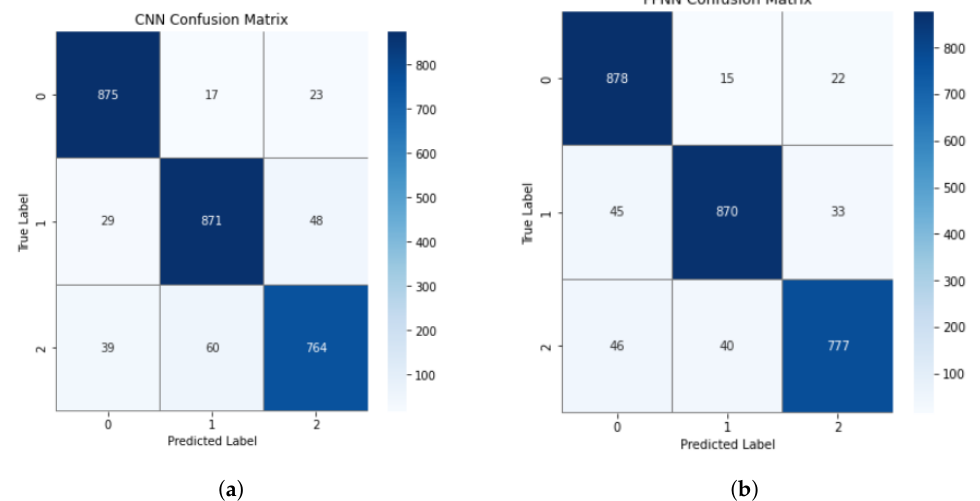
Figure 15. Confusion matrices for RU-PHS dataset classification: ( a ) CNN confusion matrix; ( b ) feed- forward NN confusion matrix. Table 10. Summary of results achieved by conventional machine learning approaches and proposed neural network architectures with five different word representations. The results in bold are the best results out of five feature extraction techniques in each model. For example, highest accuracy achieved by TF-IDF using Multinomial NB. Similarly in Neural Networks FastText(CSG) achieved highest accuracy out of four other feature extraction